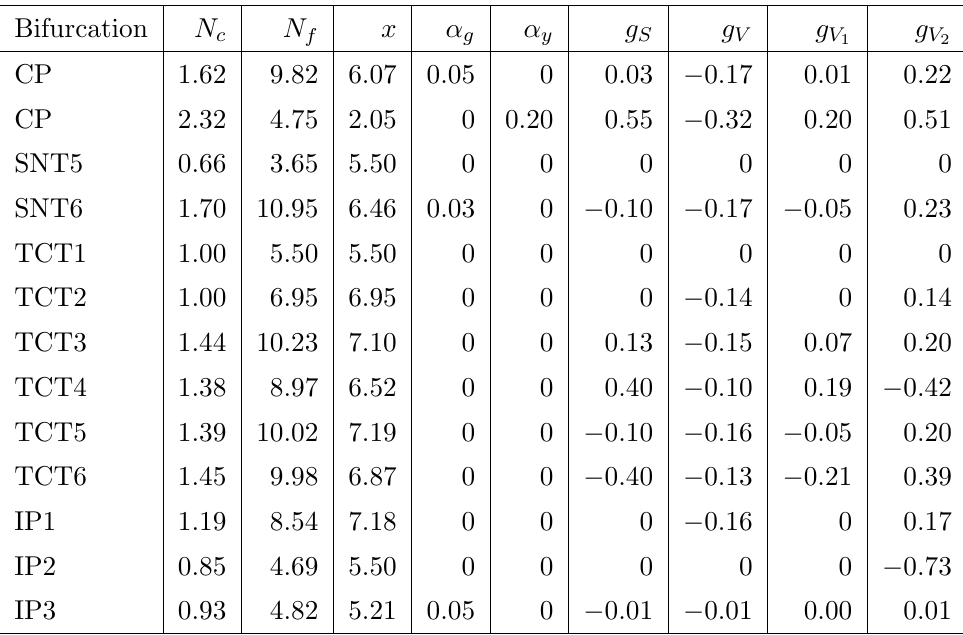
Table 7. Bifurcations found in the model of QCD